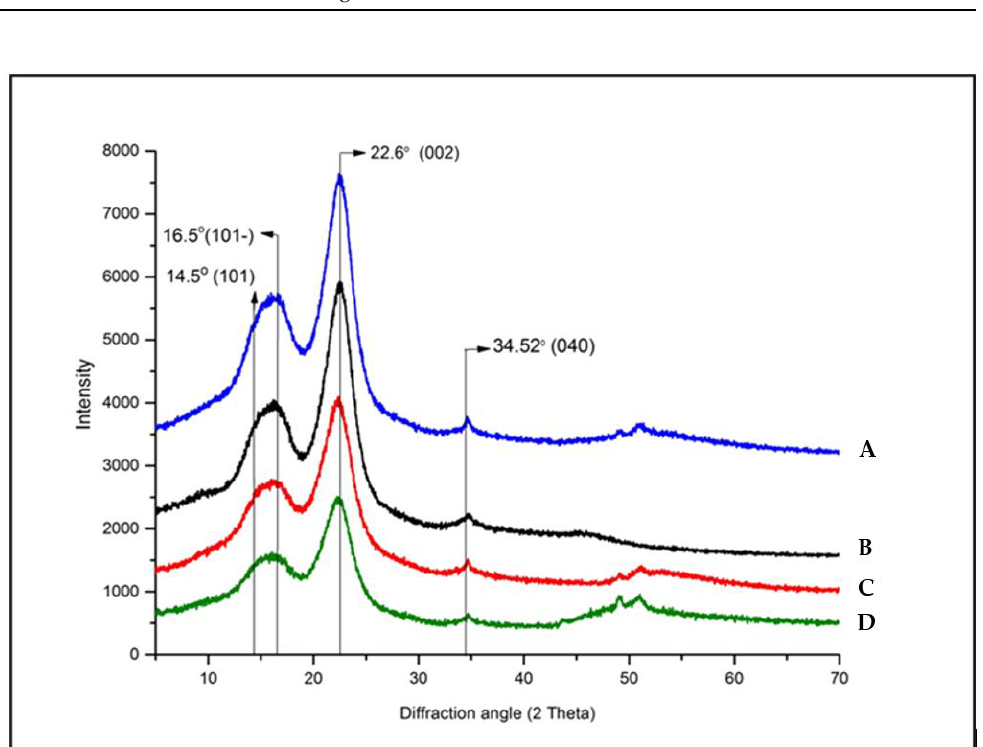
Figure 4. XRD diffractogram of non-degraded cedar wood samples (A: 21st century, B: 19th century, C: 17th century, D: 16th century).